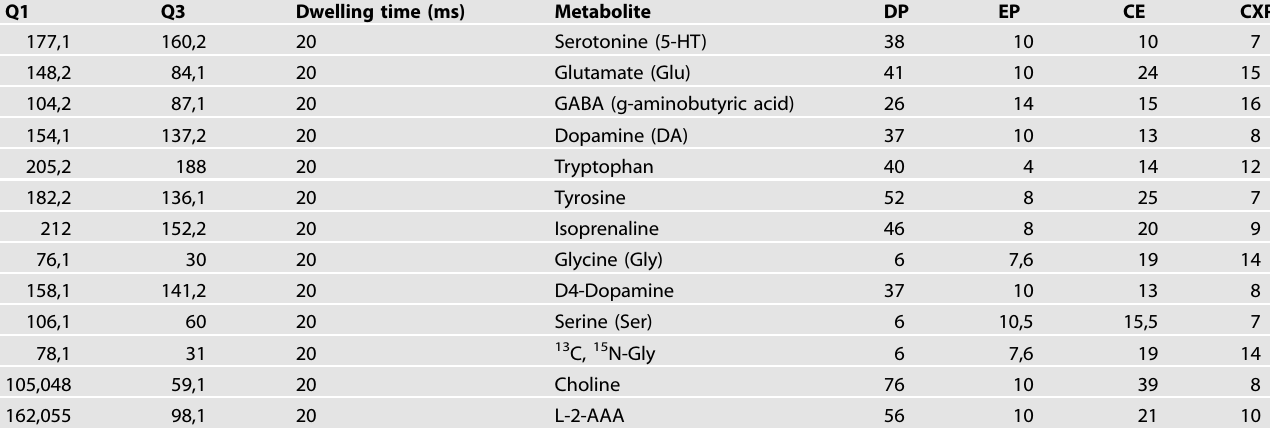
Table 2. Mass transitions and optimized mass spectrometry parameters for the neurotransmitters and internal standards in this